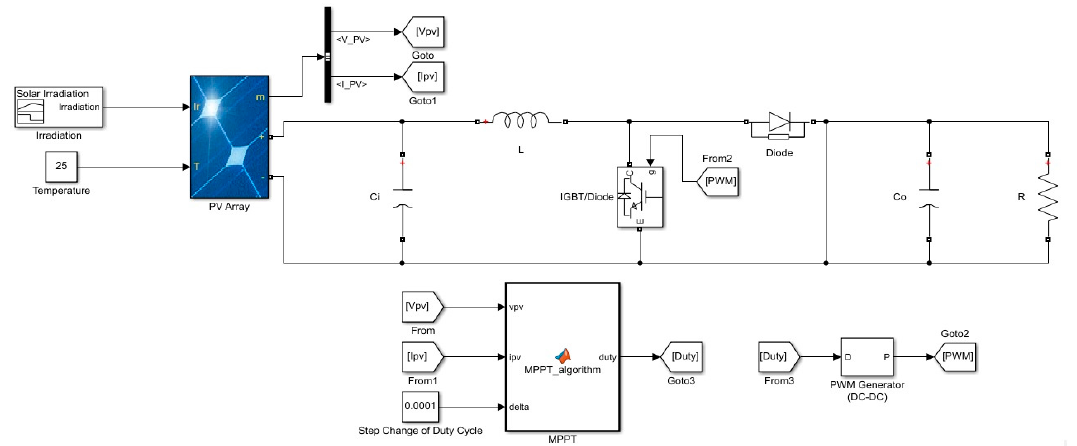
Figure 6. The model of PV array in MATLAB/Simulink.